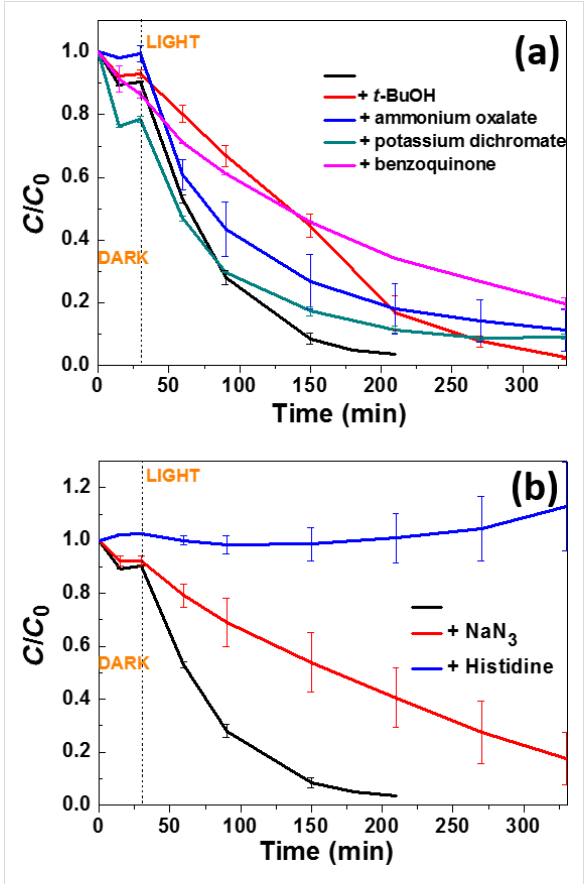
Figure 11: (a) Influence of • OH, O 2• − , electron and hole scavengers and (b) influence of 1 O 2 scavengers on the photocatalytic activity of the ZnO/ZCIS composite. The black line corresponds to the experi- ment conducted without a scavenger.